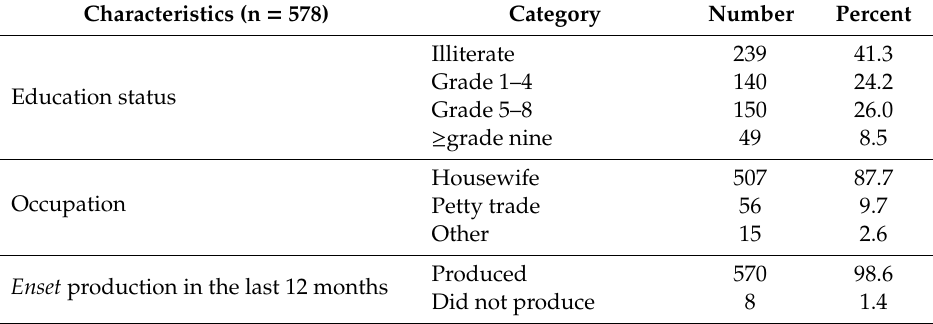
Table 1. Sociodemographic characteristics of the study’s participating mother–child pairs (MCP) (January–June